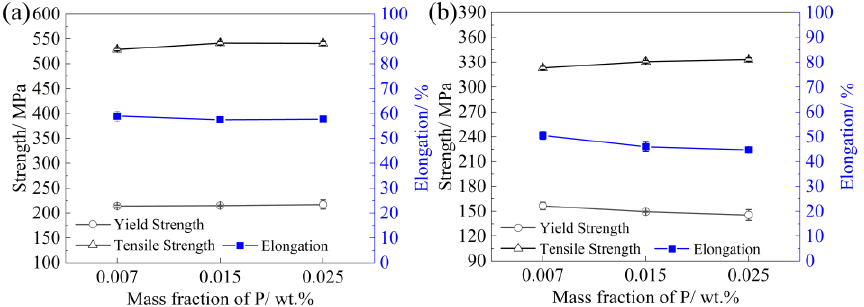
Figure 8. ( a ) Room temperature and ( b ) 650 °C tensile properties of 15Cr–15Ni–Ti–xP alloy after aging at 850 °C for 1000 h.